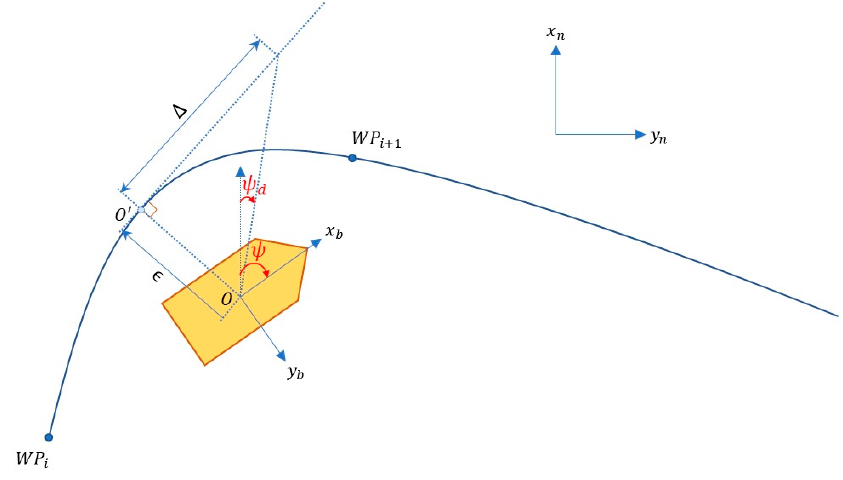
Figure 6. Continuous LOS path following.